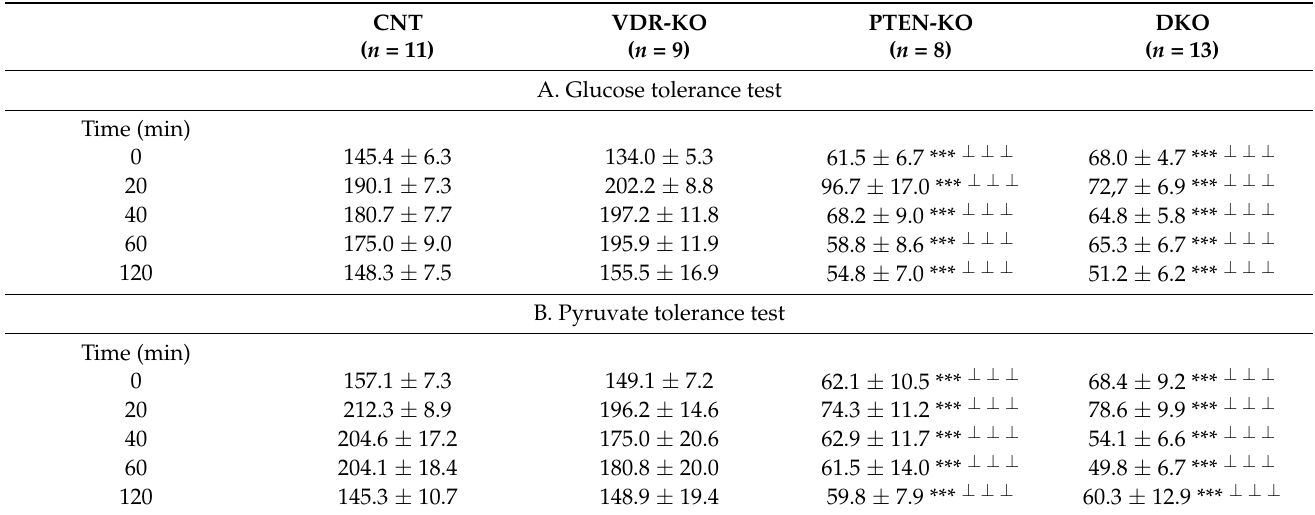
Table 2. Glucose and pyruvate